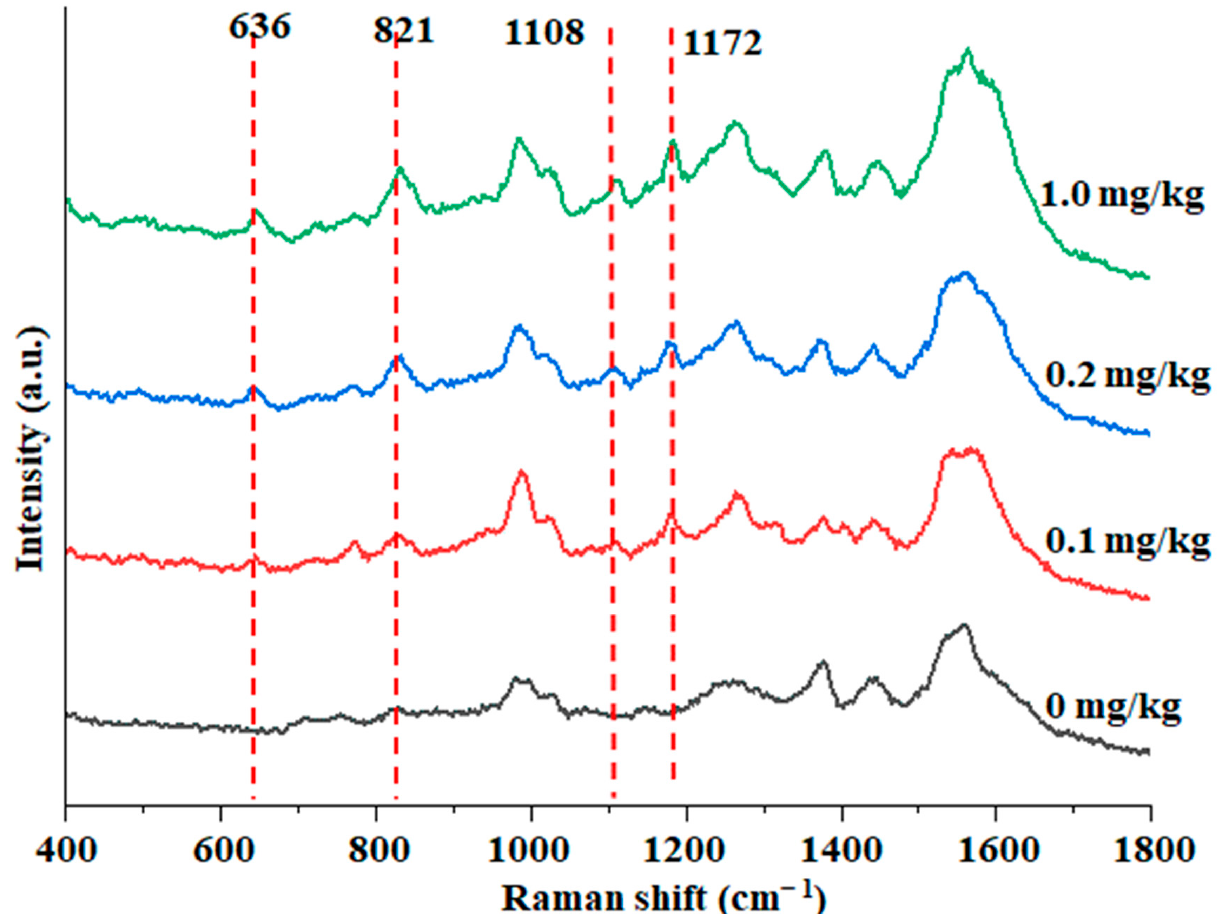
Figure 7. SERS spectra of the fish meat samples with different spiked BPA concentrations.